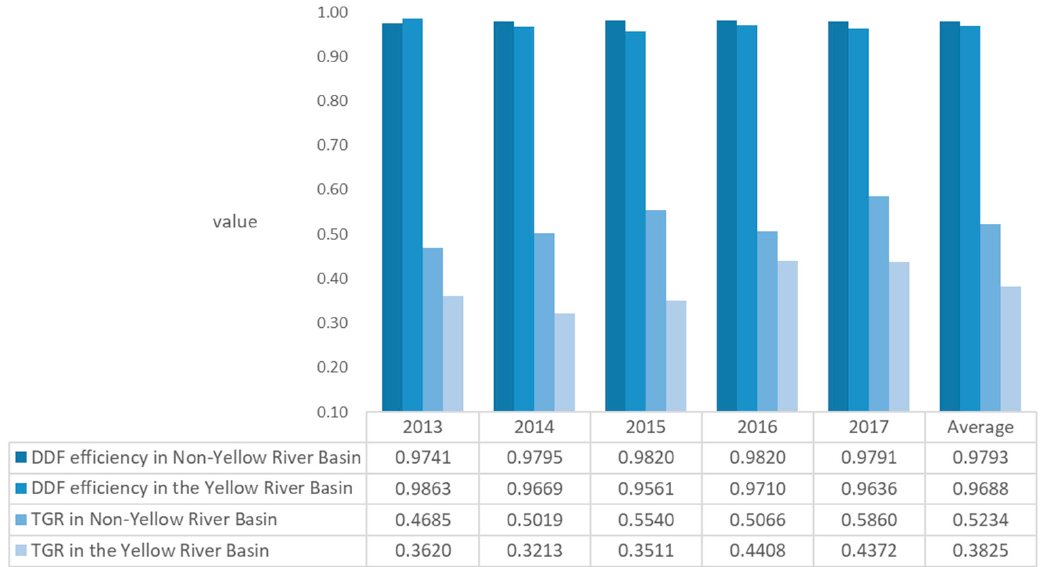
Figure 6. Analysis of DDF efficiency and TGR in the Yellow River and Non-Yellow River basins from 2013 to 2017.